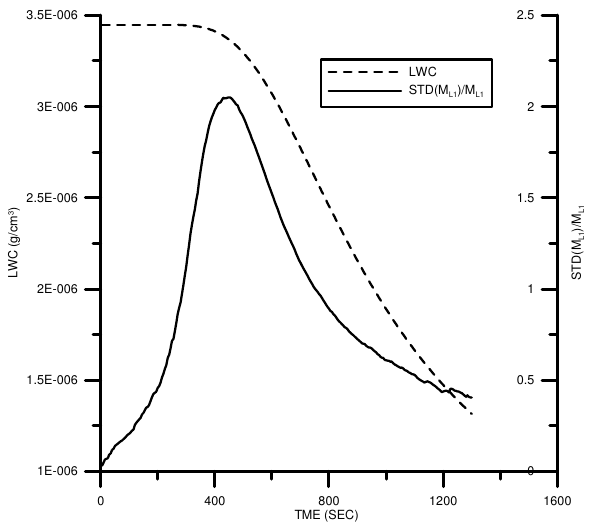
Figure 8. Same as Fig. 6 but with the initial condition (1;0) 100 N = and (2;0) 100 N = . Fig. 8. Same as Fig. 6 but with the initial condition N( 1 ; 0 ) = 100 and N( 2 ; 0 ) = 100.